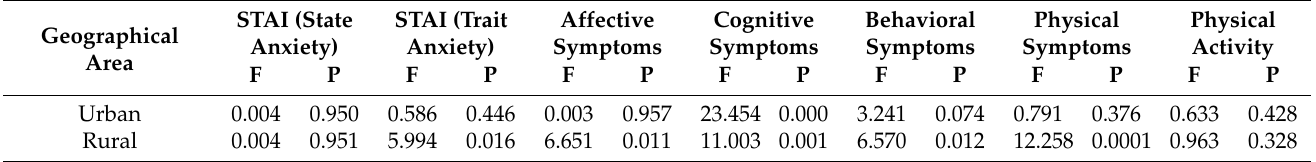
Table 6. Effects of geographical area on STAI and students’ symptoms.